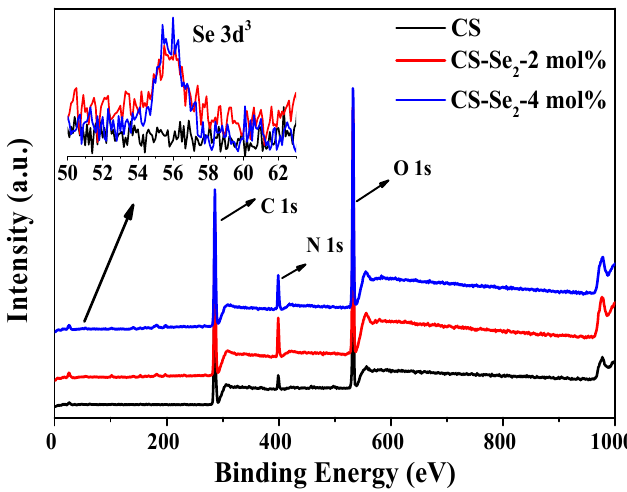
Figure 2. XPS spectra of chitosan (CS) and 2, 4 mol% Se-containing CS-Se 2 hydrogels.